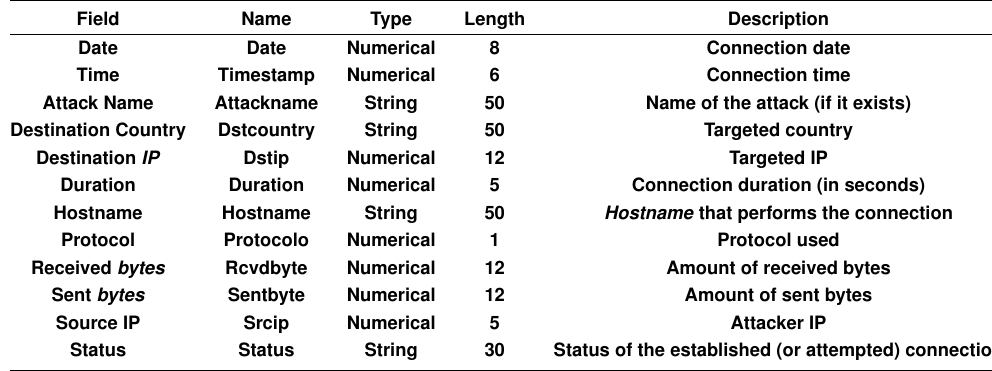
Table 1. Description of the components of the normalized log vector